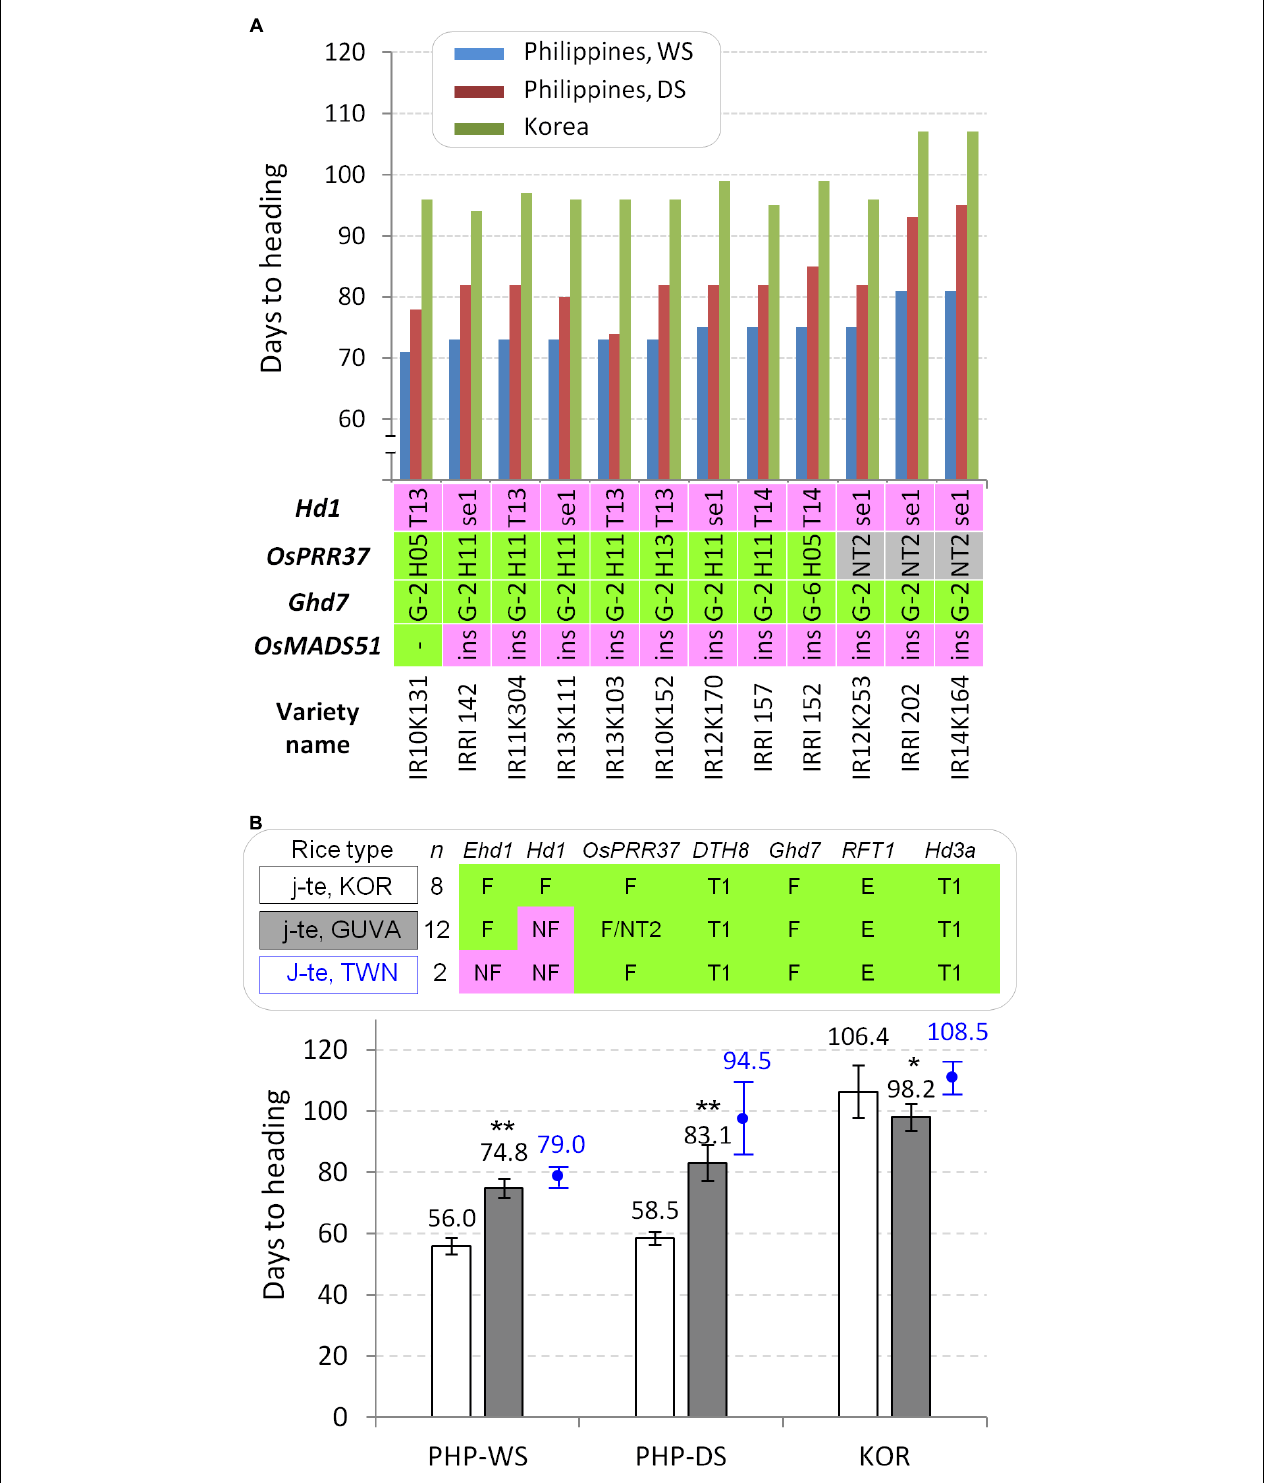
FIGURE 5 | The 12 GUVA temperate japonica lines adapted to the tropics. (A) DTH and allele types of each flowering gene. Varieties/lines are sorted by DTH at the IRRI in the wet season. All 12 lines have DTH8 -Type 1, functional Ehd1 , functional RFT1 , and Hd3a -Type 1 alleles. (B) Comparison of DTH between Korean temperate japonica varieties (j-te, KOR) and the 12 tropical zone-adapted temperate japonica varieties (j-te, GUVA) in three environmental conditions. Student’s t -test ( ∗ α = 0.05 and ∗∗ α = 0.01). As references, two Taiwanese temperate japonica varieties Taichung 65 and Tainung 67 (j-te, TWN) were presented (labeled by blue